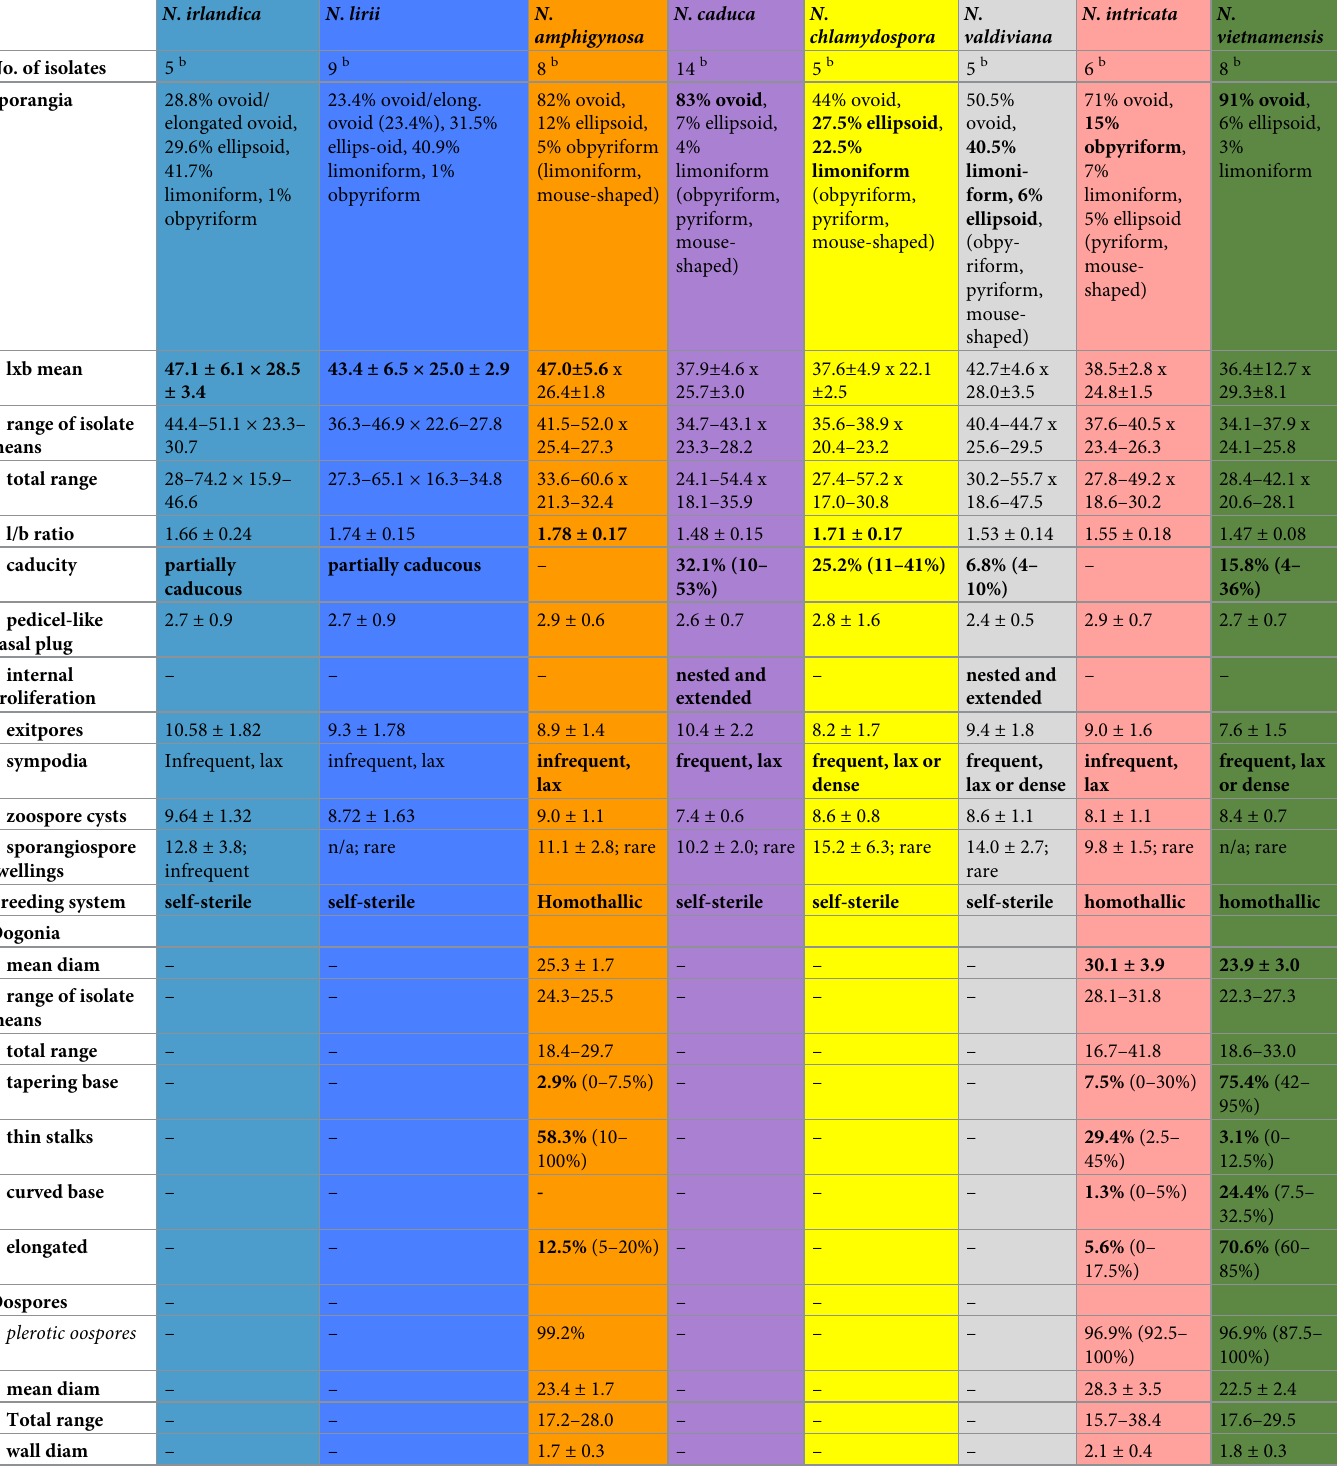
Table 2. Morphological characters and dimensions (mean ± SD; μ m), cardinal temperatures (˚C) and temperature-growth relations (mm/d) on V8-juice agar a of Nothophytophthora irlandica , N . lirii and six known Nothophytophthora species (data from Jung et al .